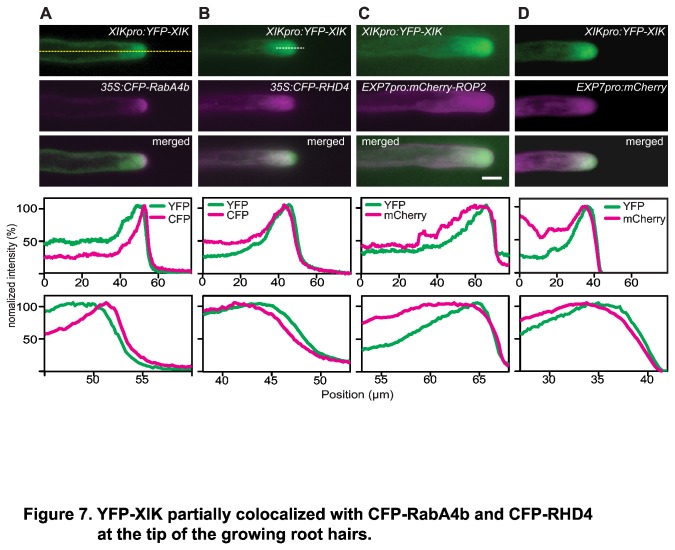
YFP-XIK partially colocalized with CFP-RabA4b and CFP-RHD4 at the tip of the growing root hairs.First row of each panel shows YFP-XIK (green) localization in the root hairs while the second row presents other markers in the same root hairs (magenta). Merged images are shown in the third row. To compare localizations, pixel intensity along the root hair center (yellow dashed line in A) of each merged image was visualized in the fourth row. Signal intensities along the first 15 μm near the tip (white dashed line in B) are shown to emphasize the distribution of the two proteins near the tip of root hairs (fifth row). Scale bar indicates 10 μm.(a) Partial colocalization of CFP-RabA4b and YFP-XIK. Although CFP-RabA4b and YFP-XIK localized at the tip of root hairs, CFP-RabA4b proteins accumulated closer to the apex while YFP-XIK signal was maximal in the subapex of the root hairs. Also compare Movie S6.(b) Partial colocalization of CFP-RHD4 and YFP-XIK. CFP-RHD4 labeled vesicles accumulated further away from the root hair tip than YFP-XIK which resulted in partial overlap with the YFP-XIK signal.(C) mCherry-ROP2 localization in cytosol and plasma membrane. Localization of YFP-XIK was clearly distinguishable from both inactive mCherry-ROP2 in the cytosol and active mCherry-ROP2 at the plasma membrane.(D) Distribution of cytosolic mCherry was different from YFP-XIK localization at the root hair tip suggesting that accumulation of YFP-XIK at the tip did not reflect free diffusion.